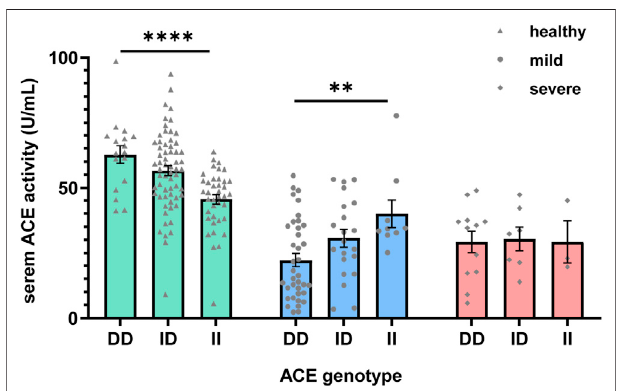
FIGURE 1 | Mean serum angiotensin-converting enzyme (ACE) levels of COVID-19 patients with different ACE genotypes and different symptoms. Serum ACE levels and the ACE genotypes showed signi fi cant correlation with different symptoms of the COVID-19 patients [two-way ANOVA, F (4, 198) (cid:1) 6.743, p value < 0.0001]. The mean serum ACE level without any regard to the genotype reduced during the COVID-19. Data are presented as mean